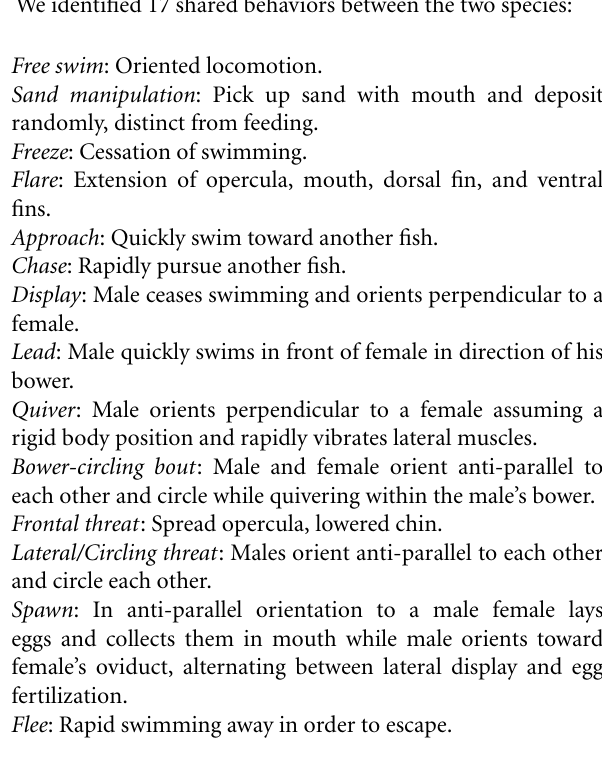
substrate, as observed for the Malawi rock-dweller Labeotropheus fuelleborni (Alberston and Kocher,